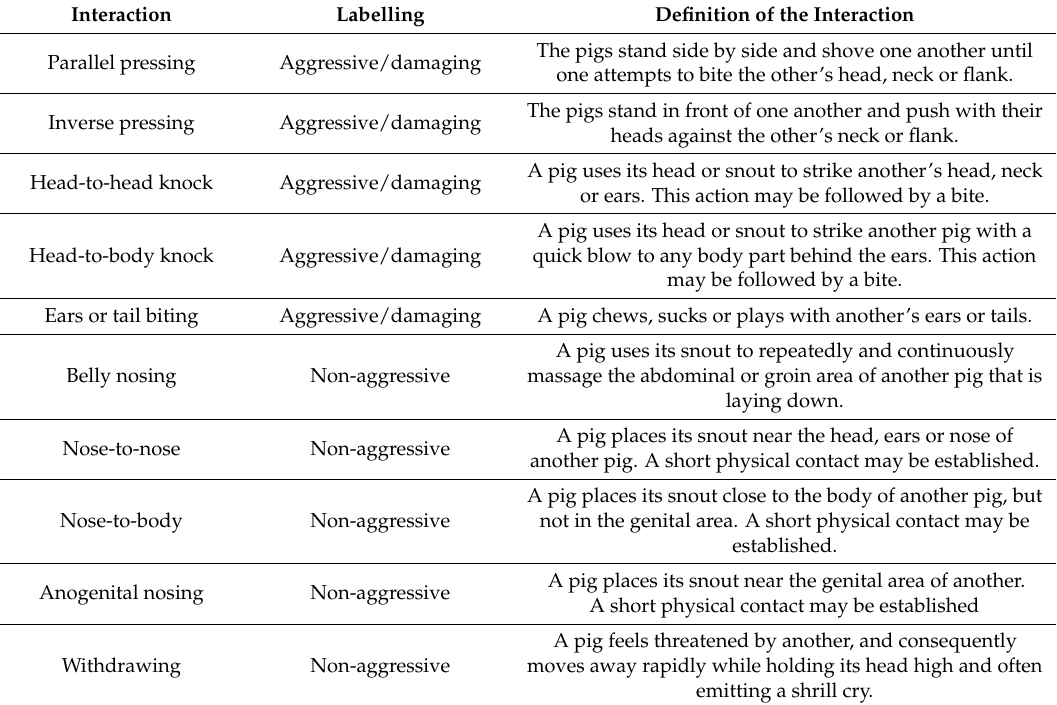
Table 2. Description of the observed social